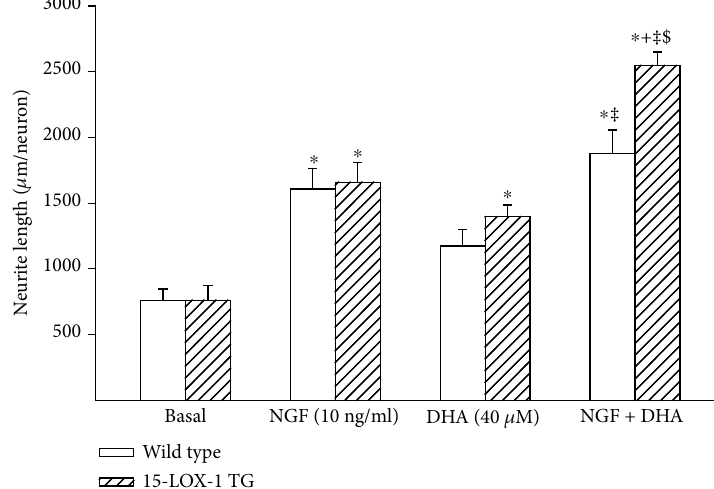
Figure 7: E ff ects of nerve growth factor (NGF), docosahexaenoic acid (DHA), or NGF + DHA on neurite growth by dorsal root ganglion neurons derived from wild-type and 15-LOX-1 transgenic mice. Dorsal root ganglion neurons were collected and cultured as described in Section 2. Afterwards, the e ff ects of nerve growth factor (10 ng/ml), docosahexaenoic acid (40 μ M), or the combination of NGF + DHA on neurite outgrowth were determined. Data are presented as the mean ± SEM in μ m per neuron. The number of mice used per group was 9. ∗ p < 0 : 05 compared to their respective basal; + p < 0 : 05 compared to their respective NGF-treated neuron; ‡ compared to their respective DHA-treated neurons; $ compared to wild-type combined NGF + DHA -treated